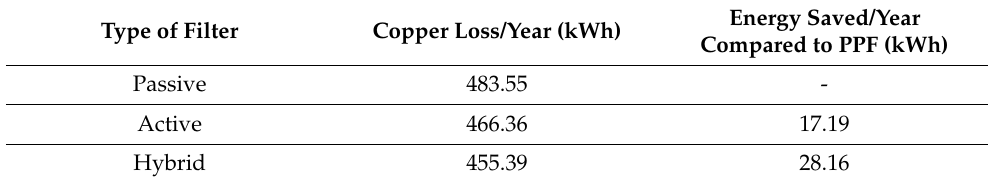
Table 4. Energy saving by reducing copper loss by various